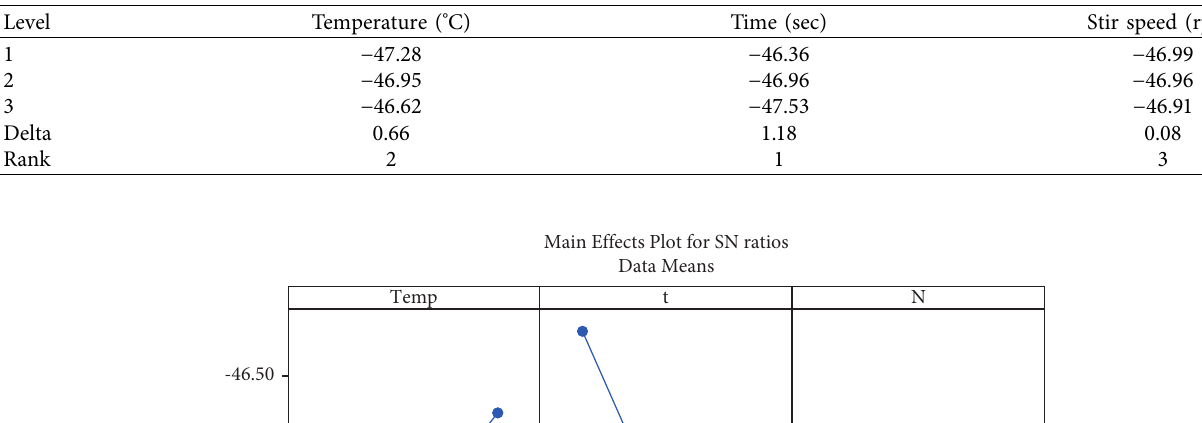
Table 4: Porosity and compressive strength-based responses.